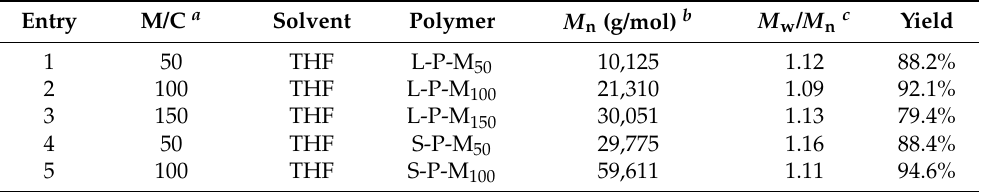
Table 1. Polymerization results of PQASs with palladium catalysts as initiator at 55 °C .